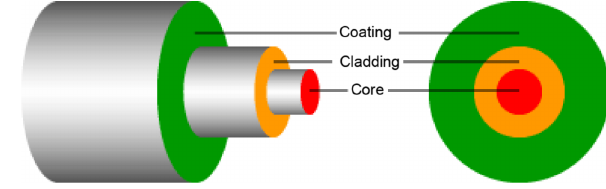
Figure 2. Optic Fiber structure, © National